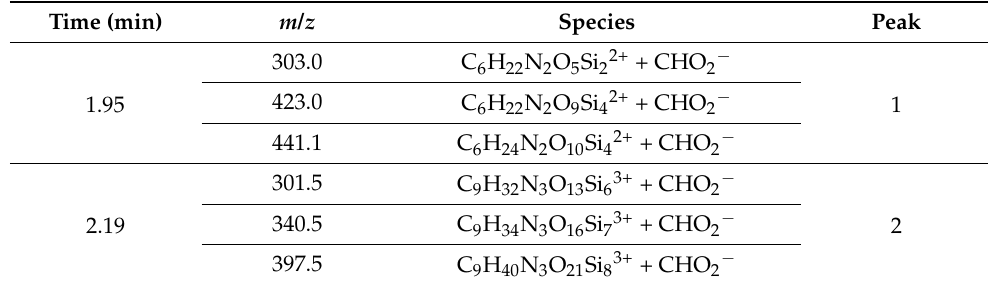
Figure 5. As illustrated by study of peak 6 fragment, different hydrolysis and condensation reaction can occur leading to addition or removal of H 2 O to the structure. ( A ) Scheme of successive siloxane bridge hydrolysis going from n = 4 to n = 0 on fragment detected at m / z = 724.6. ( B ) Zoom on the related peak 6 MS spectra area (710–770 m / z ) where the successive m / z of hydrolyzed fragment can be found. Table 1. Proposed fragments formula for m / z observed in MS spectra of peak 1 to 7, with associated retention time from 1.95 to 4.05